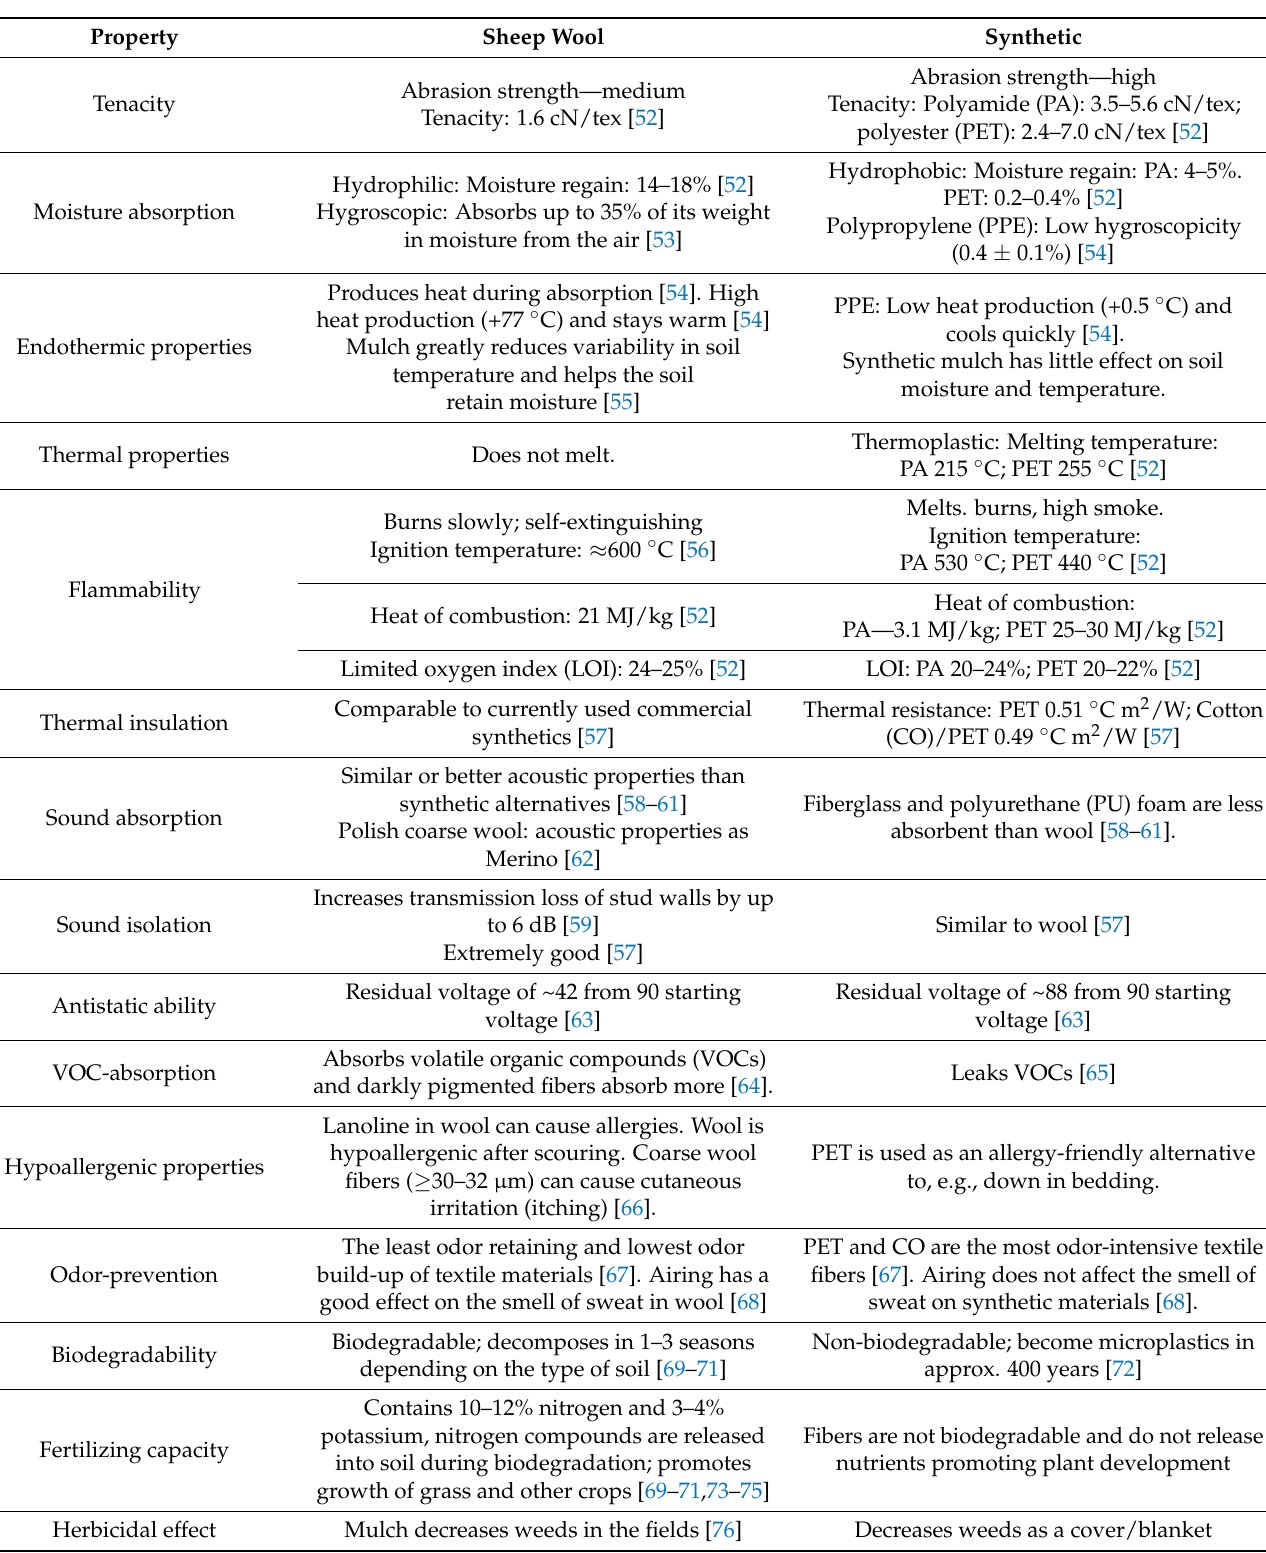
Table 1. Comparison of properties for sheep wool and synthetic materials, both